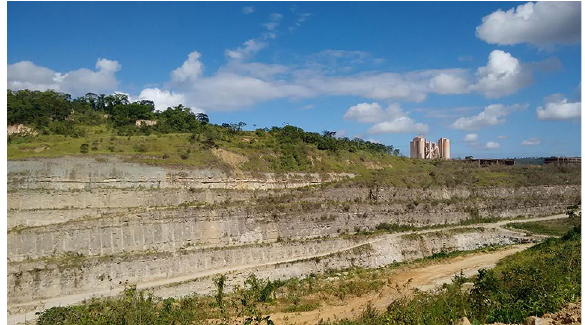
Fig. 1 Overview of Atol Quarry Complex, located in the town of São